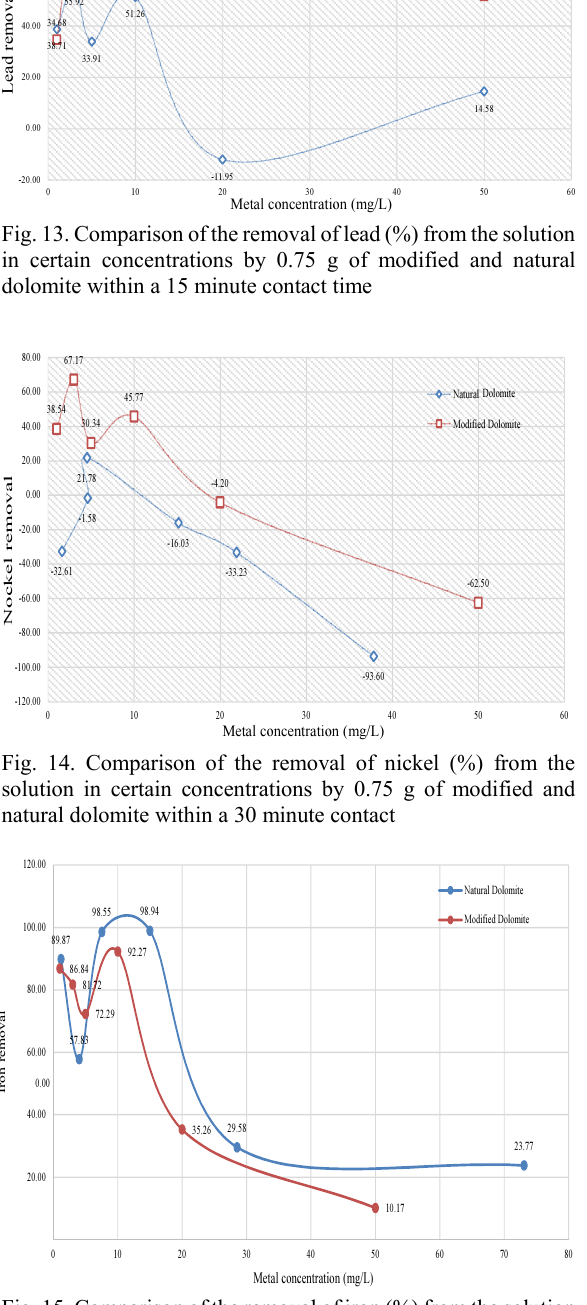
Fig. 15. Comparison of the removal of iron (%) from the solution in certain concentrations by 0.1 g of modified and natural dolomite within a 60 minute contact time